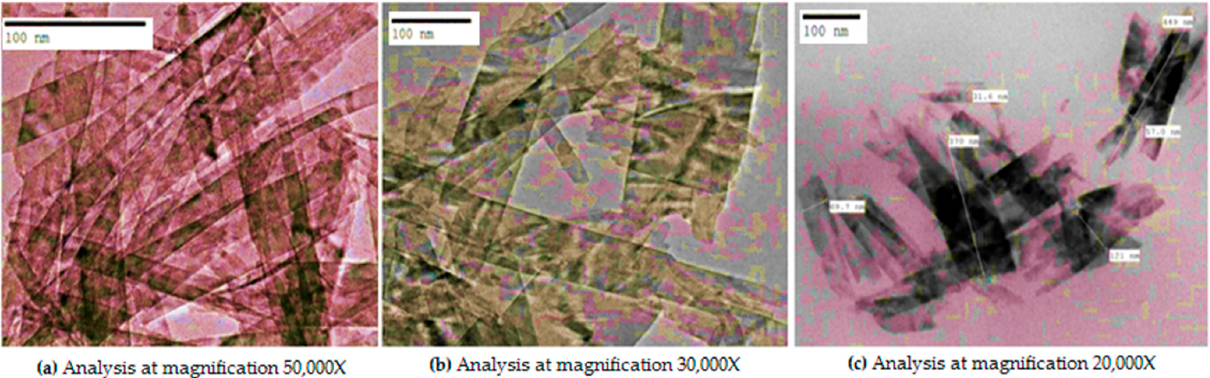
Figure 2. TEM analysis of CuO nano-rods synthesized from Momordica charantia.